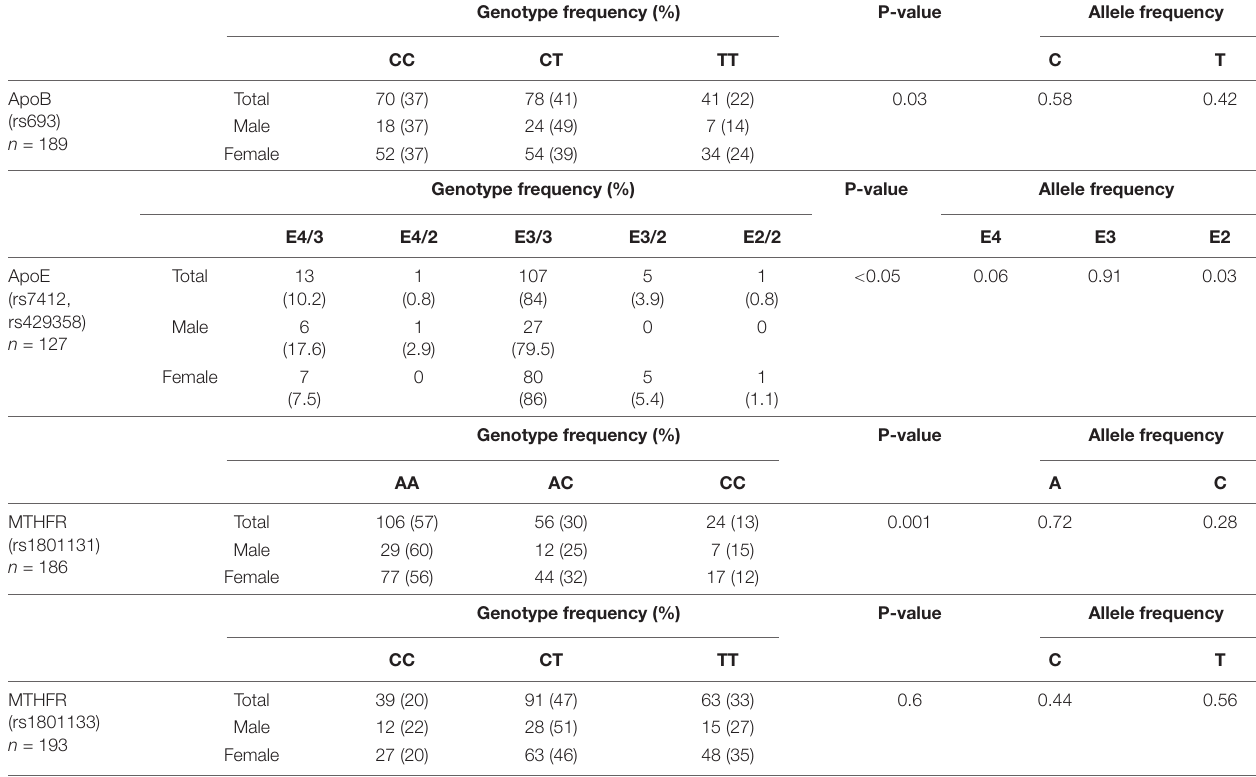
TABLE 2 | Genotype distribution and relative allele frequency for ApoB, ApoE, and MTHFR polymorphisms. Genotype frequency